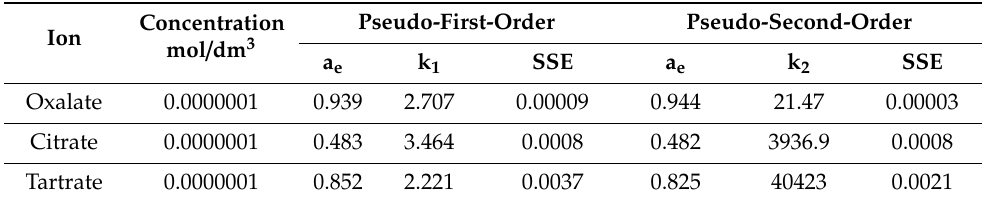
Table 1. Parameters of the pseudo-first-order and the pseudo-second-order equations fitted to the data of adsorption kinetics of oxalate, citrate and tartrate ions from the solutions of the initial concentration 0.000001 mol / dm 3 on the hydroxyapatite.